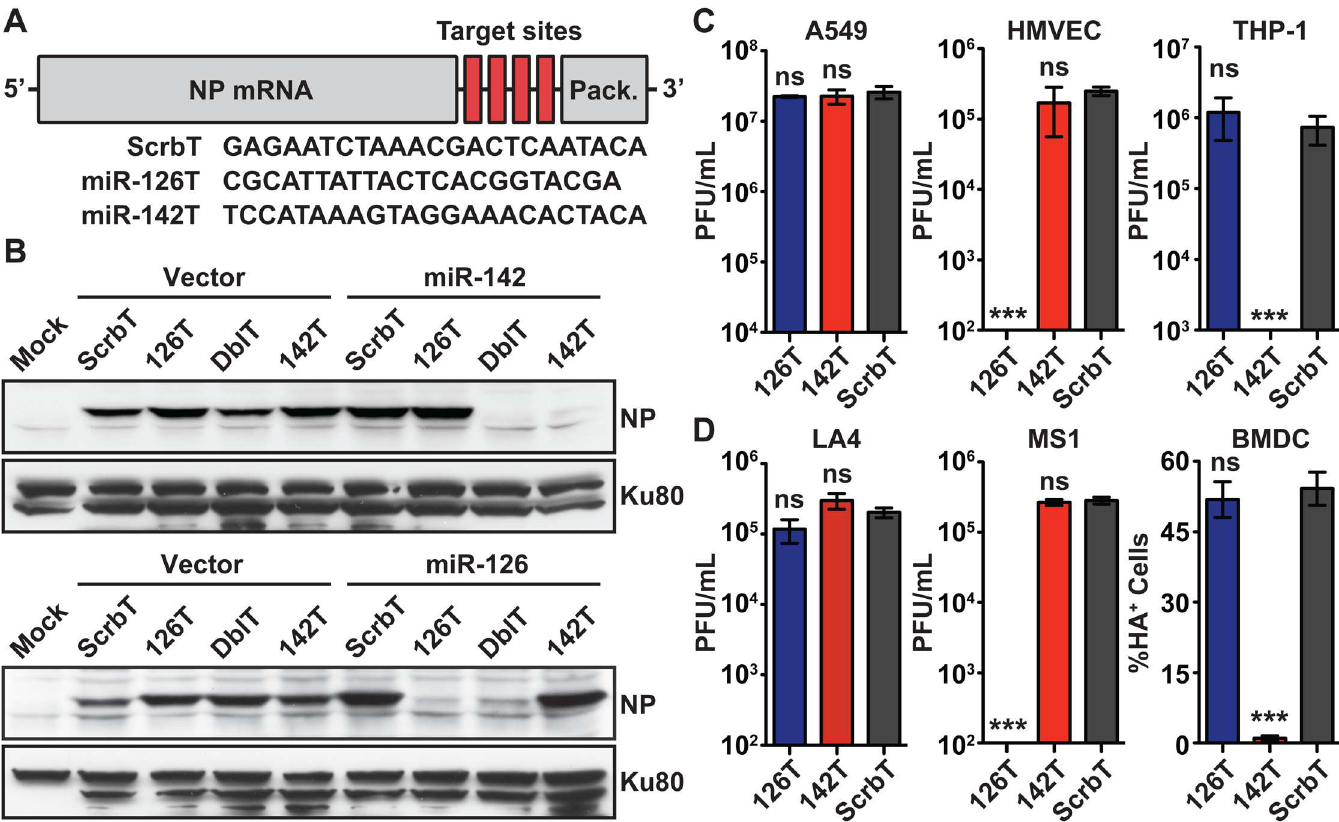
Fig 1. Generation and characterization of H5N1 viruses with restrictedtropism. (A) Schematic representation of NP mRNA carryingfour copies of miRNA target sites in the 3’UTR. The incorporated target sequences,which are Complementary to the mature miRNA, are shown below. (B) Evaluation of miRNA mediatedrestriction of NP expression. HEK-293T cells were co-transfected with plasmidsexpressingspecific miRNAs (vector, miR142, miR126)and NP with miRNA target sites, and NP expressionwas analyzedby western blot. DblT refers to the NP segment carrying two miR-142-3p and two miR-126-3p target sites. Expression of Ku80 is shown as a loadingcontrol. (C-D) Evaluation of tropism restricted H5N1virus replicationin humanand murine cells. (C) Human epithelialcells (A549, MOI = 0.001), endothelialcells (HMVEC, MOI = 0.01), monocytic leukemiacells (THP-1, MOI = 3), and (D) mouse epithelial cells (LA-4; MOI = 1), endothelial cells (MS1, MOI = 1) and dendritic cells (BMDC, MOI = 0.1) were infected with tropism restricted H5N1viruses and viral titers at 48 hrs pi (hpi) were determinedby plaqueassay for all but BMDC. The titers are shown as PFU/mL (mean ± SEM). The limit of detectionis 10 PFU/ mL. For BMDC, the level of infectionat 24hpi was measuredby flow cytometry using an anti-H5antibody. Data is represented as percentage of HA + cells in the CD11c + population(mean ± SEM). Asterisk denotesstatistical significance determinedby one-wayANOVA in comparisonto H5N1-ScrbTgroup and the values are denotedas * p < 0.05, ** p < 0.01, *** p < 0.001and ns–non significant.Data presented here is a representative of at least three independent experiments performed in triplicate. https://doi.org/10.1371/journal.ppat.1006270.g001 mouse cell lines (S1 Table; Fig 1D and S1 Fig). In agreement with our observations in human cells, all three viruses replicated to equivalent levels in mouse lung epithelial cells (LA4), and